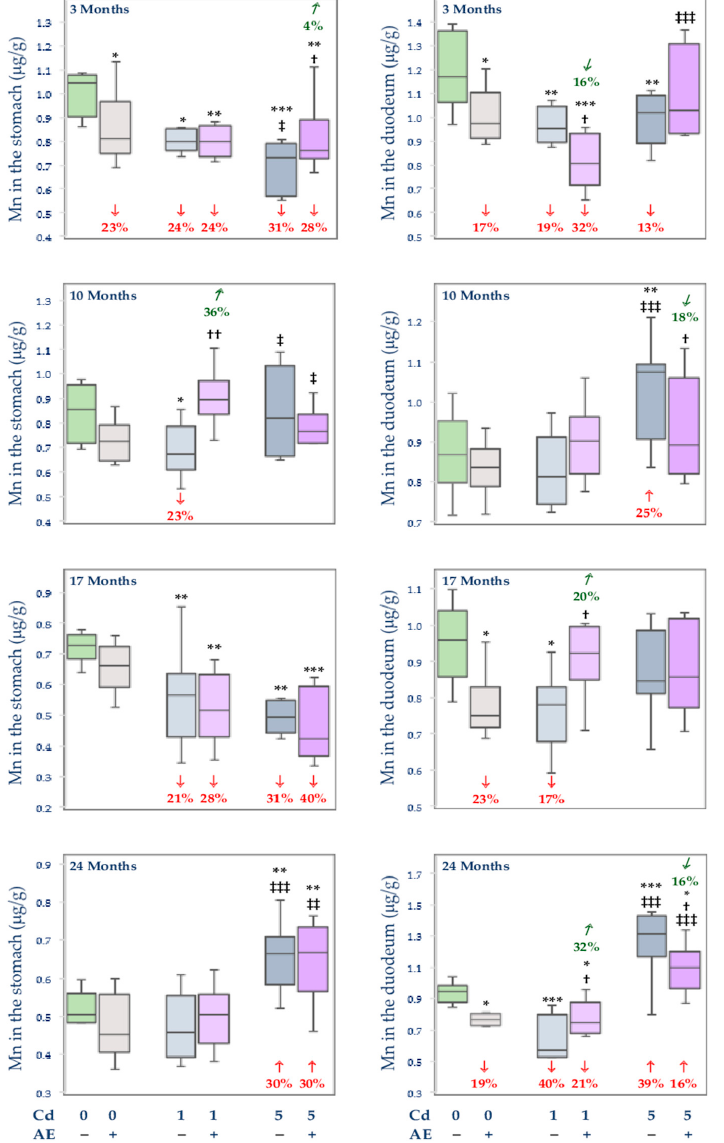
Figure 3. The concentration of Mn in the stomach and duodenum in particular experimental groups. The rats received Cd in the diet at the concentration of 0, 1, and 5 mg/kg and/or 0.1% AE as the only drinking fluid (“+”, administered; “ − ”, without administration). Data represent a median and 25–75% confidence interval (the horizontal lines within the bars presenting the confidence interval represent median values), as well as the minimum and maximum values for eight rats in each experimental group (except for seven animals in the AE, Cd1, and Cd5 groups after 24 months). Statistically significant differences: * p < 0.05, ** p < 0.01, *** p < 0.001 vs. control group; † p < 0.05, †† p < 0.01 vs. respective group receiving Cd alone (Cd1 or Cd5 group); ‡ p < 0.05, ‡‡ p < 0.01, ‡‡‡ p < 0.001 vs. respective group receiving the 1 mg Cd/kg diet alone (Cd1 group) or with the AE (Cd1 + AE group) are marked. The values below and above the bars indicate percentage changes compared to the control group ( ↓ , decrease; ↑ , increase) or the respective group receiving Cd alone ( , increase),